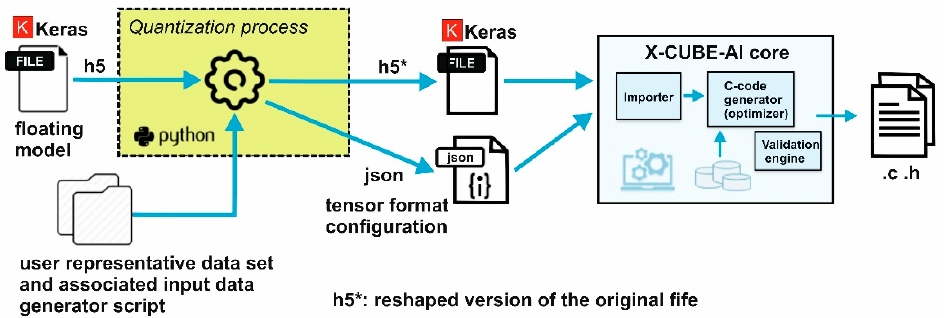
Figure 5. Generation and implementation of the pre-quantized Keras model.